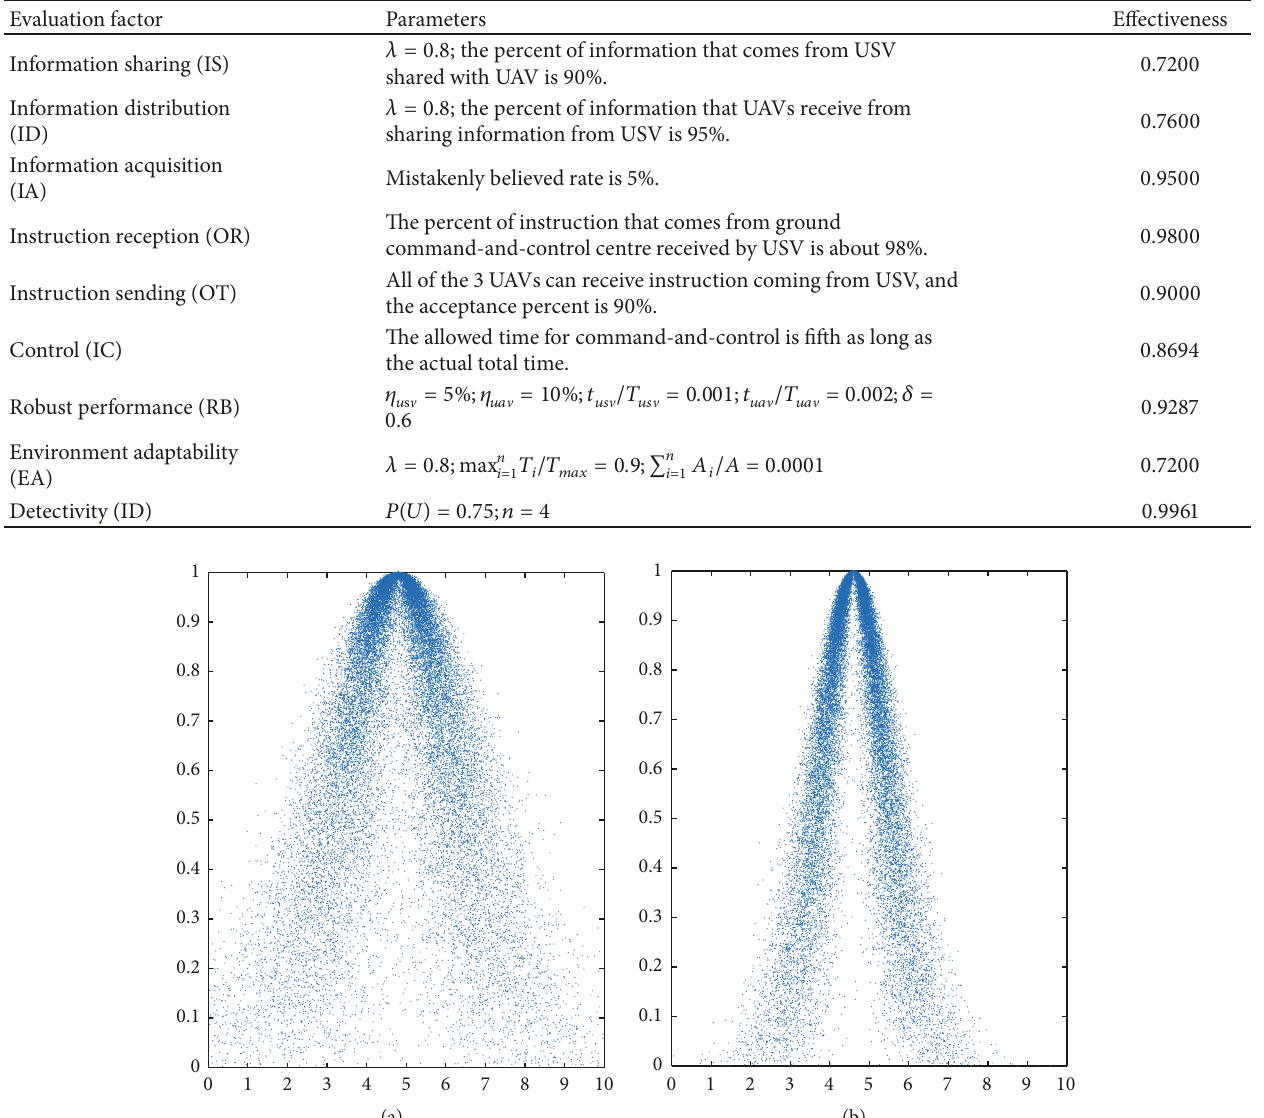
Table 1: The relative parameters and effectiveness of each evaluation factor.